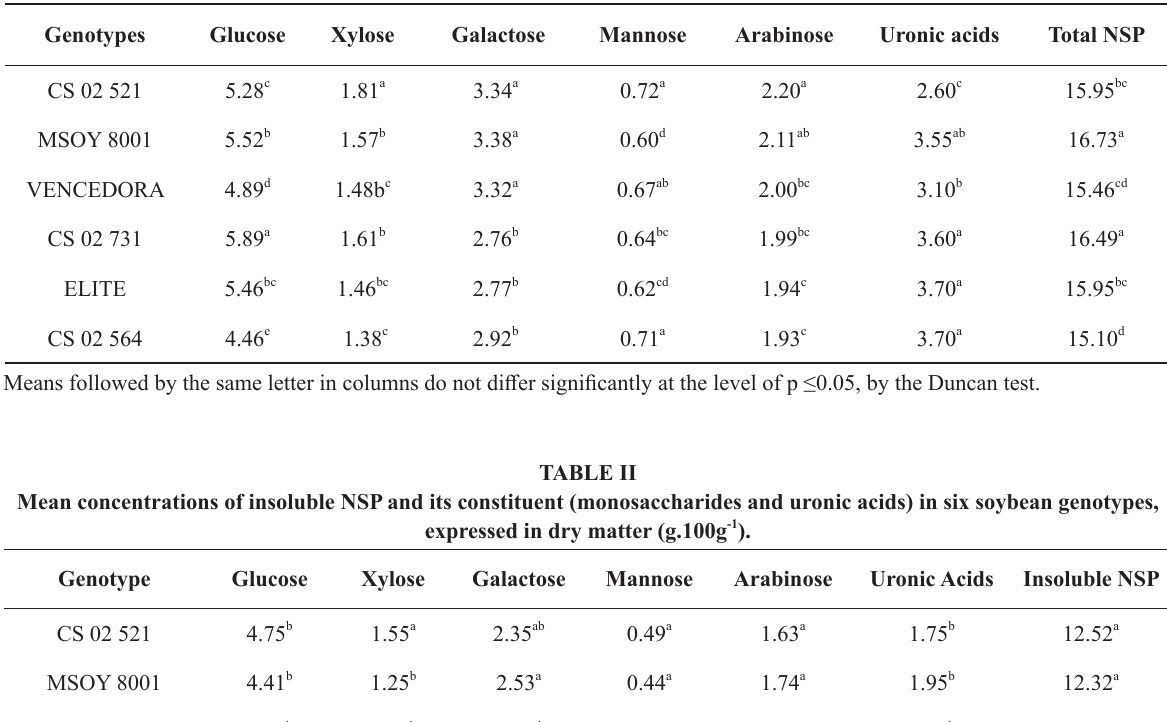
Mean concentrations of total NSP and its constituent (monosaccharides and uronic acids) in six soybean genotypes, expressed in dry matter (g.100g -1 ).